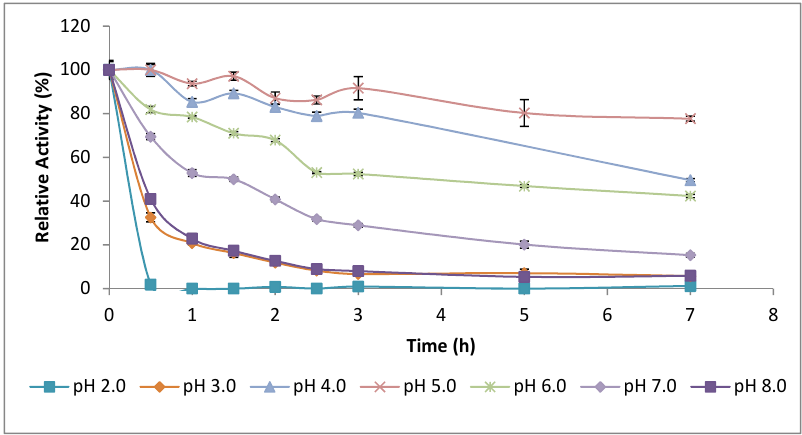
FIGURE 4 - Relative stability of bromelain in several pH at 50 °C. The error bars refer to standard